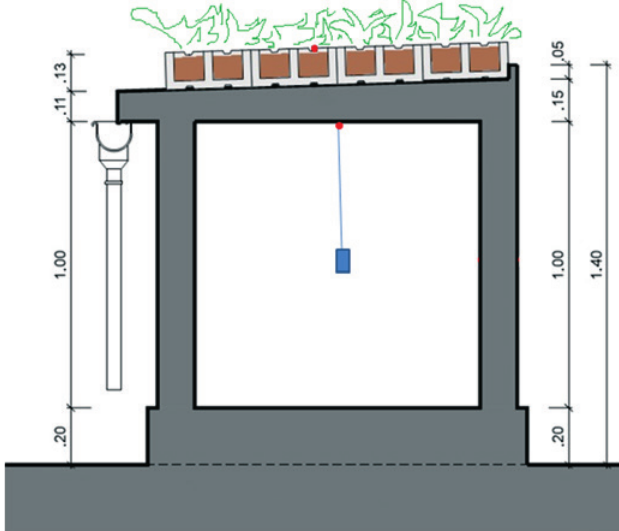
Positioning of the Datalogger (geometric center of the internal space) and of the thermocouples on the surfaces of the internal and external sides of the prototypes’ covers (red points)